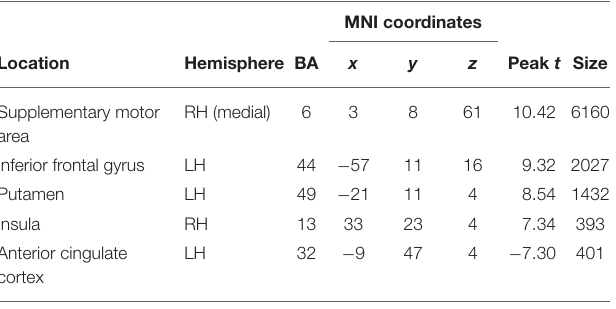
TABLE 2 | Cluster location and peaks across age groups (RM + RV >